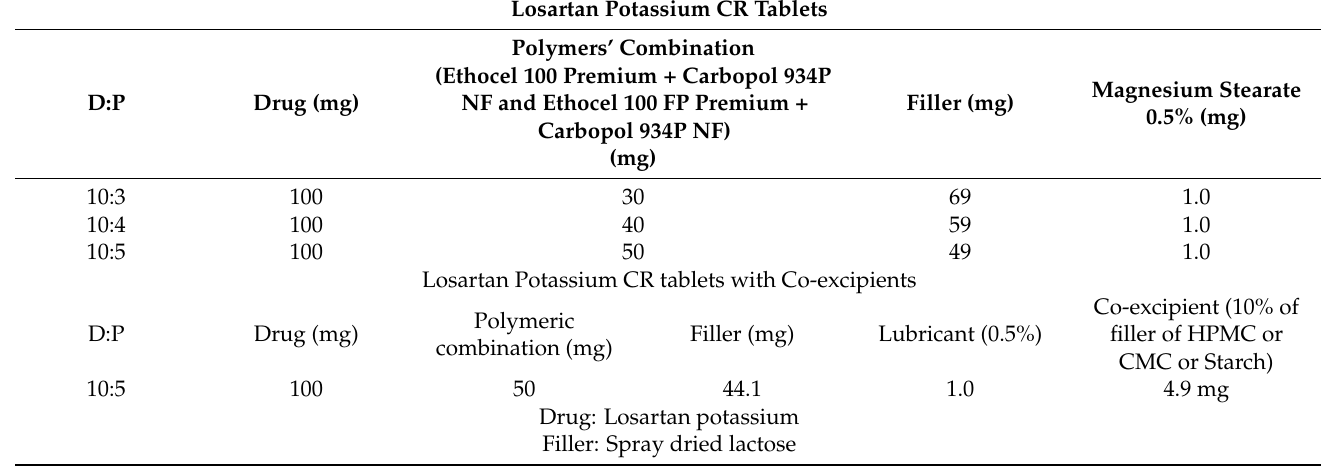
Table 1. Composition of